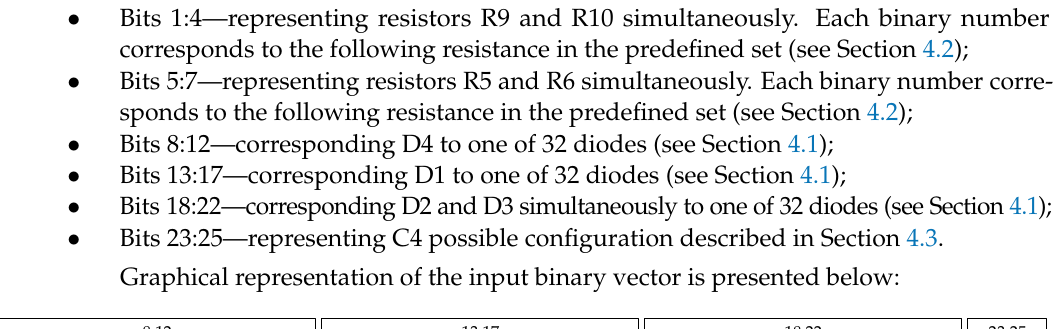
Figure 6. Implemented algorithm